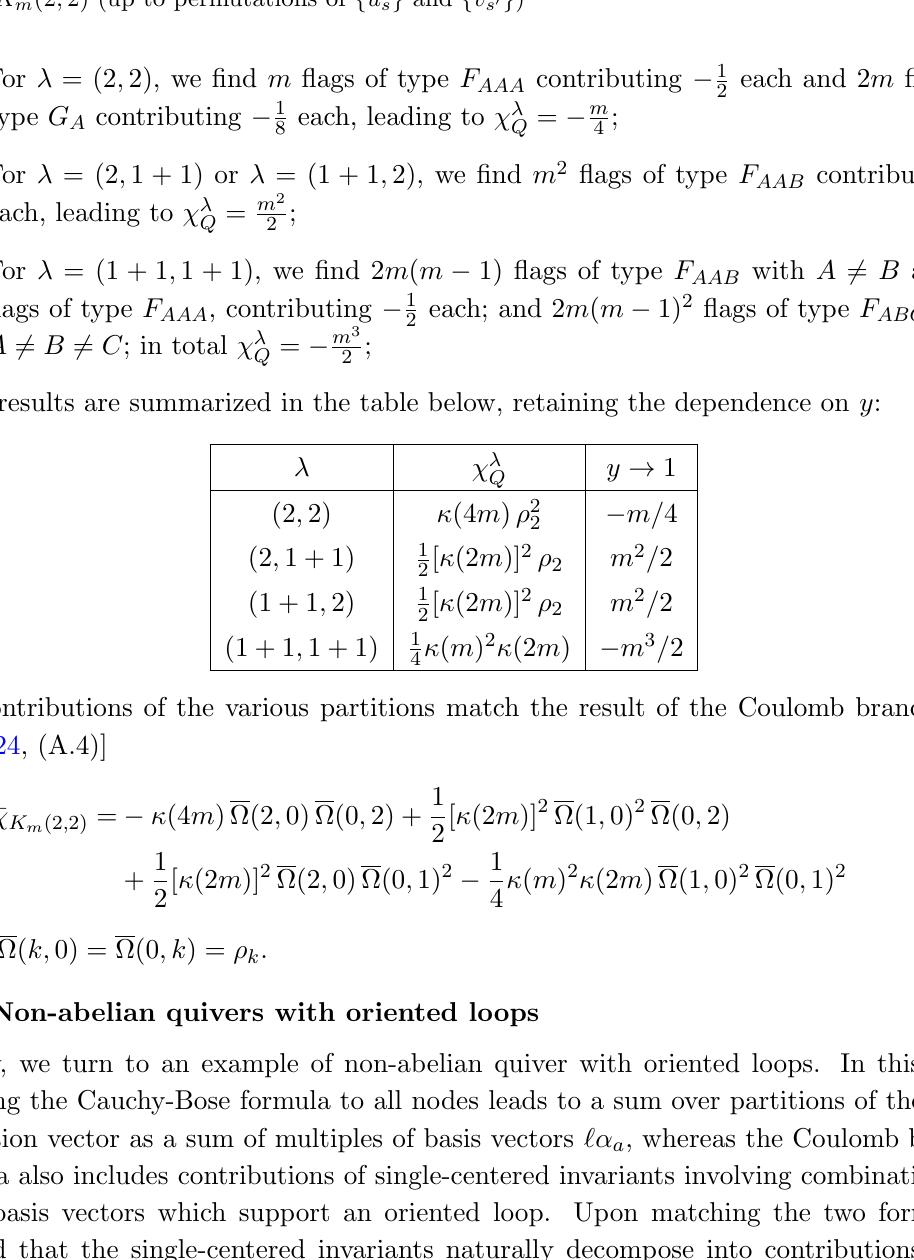
Figure 3 . Graphs associated to the (cid:13)ags contributing to the equivariant (cid:31) -genus of the Kronecker quiver K m (2 ; 2) (up to permutations of f u s g and f v s 0 g